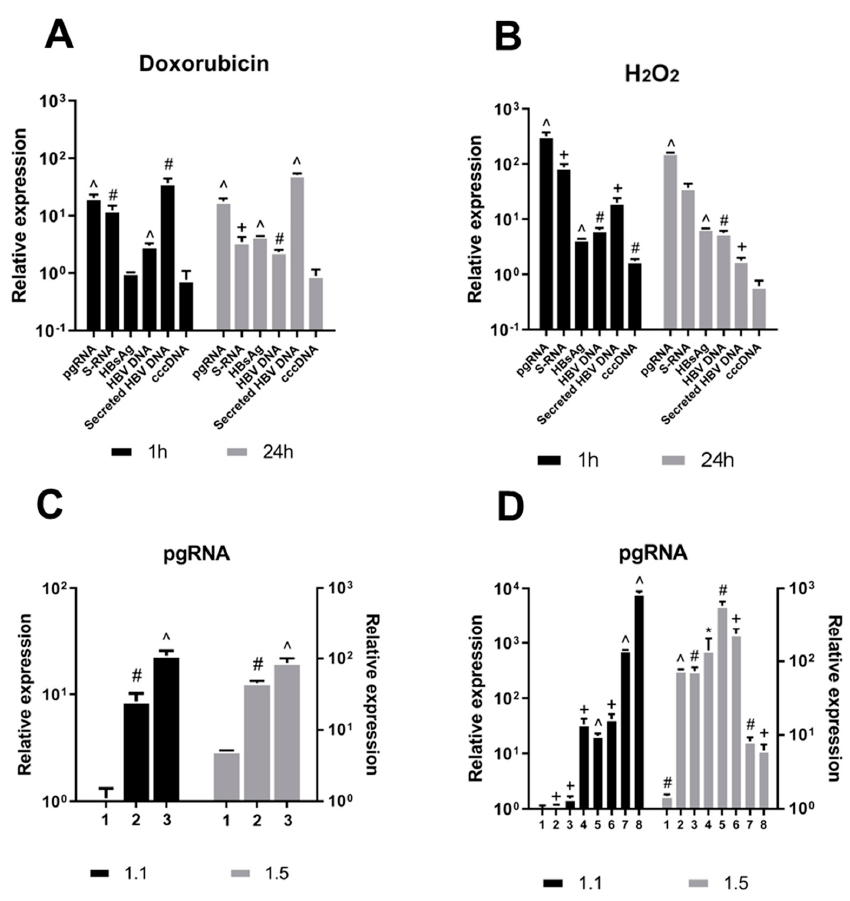
Figure 1. Upregulation of HBV replication by DNA-damaging agents. Alterations in HBV intermediates (pgRNA, S-RNA, intracellular HBV DNA, secreted HBV DNA and secreted HBsAg) upon ( A ) doxorubicin and ( B ) H 2 O 2 treatment in HepG2-1.1merHBV cells. Data are relative to mock-treated control. Effects of increasing doses of ( C ) doxorubicin and ( D ) H 2 O 2 on pgRNA levels in HepG2-1.1merHBV cells (1.1) and HepG2-1.5merHBV cells (1.5). X-axis represents different doses of doxorubicin and H 2 O 2 as specified in Table 1. The results were reproduced in at least 3 independent experiments. Asterisks indicate statistically significant differences in means compared to control. * p < 0.05, + p < 0.01, # p < 0.001, ^ p < 0.0001. Collectively, these results demonstrated that DNA damage caused by doxorubicin and H 2 O 2 (doxorubicin inducing DSBs and H 2 O 2 , SSBs) leads to the upregulation of HBV transcription through a mechanism associated with the upregulation of ATM and ATR transcription.